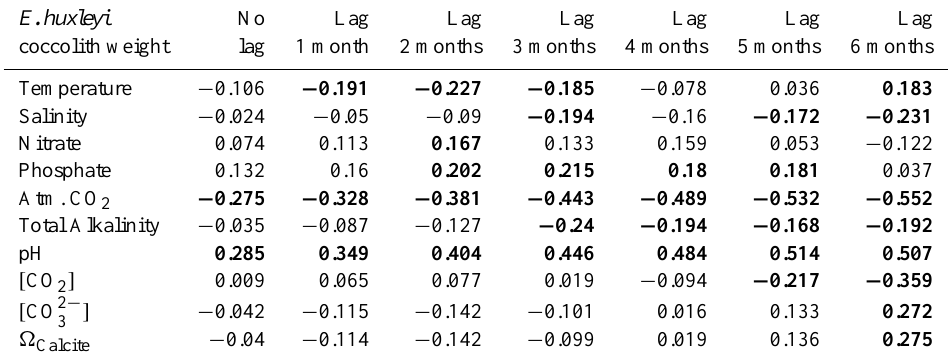
Table 1. Cross-correlation between E. huxleyi coccolith weight and time-series parameters, calculated for lags of 0 to 6 months. Significant correlations are set in bold.